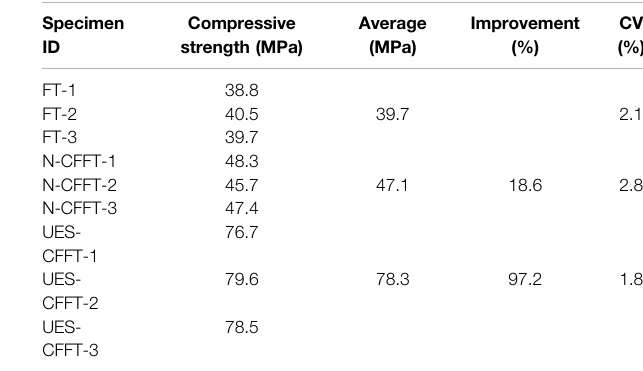
TABLE 6 | Compressive strength results of the three types of specimens under